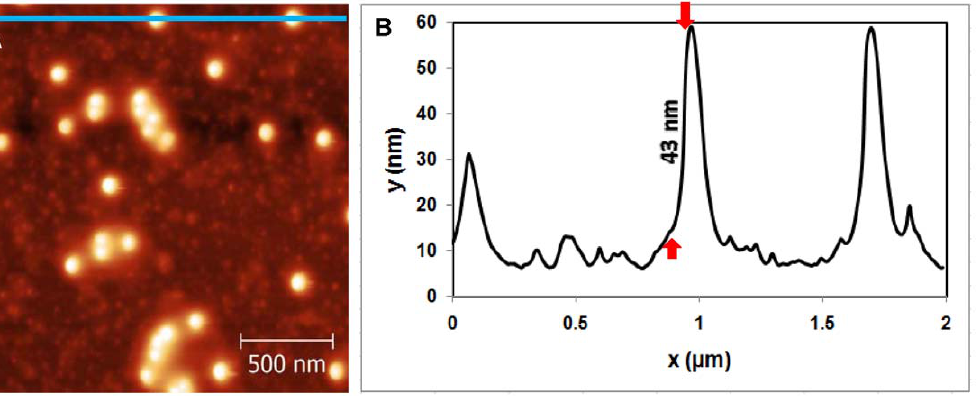
Figure 4. Topography of Mica/GaAl 12 /APTES/Phage l /UV sample. (A) AFM image of virus solution adhered on mica after the 15 min UV exposure. (B) Cross sectional image along the blue line shown in (A).